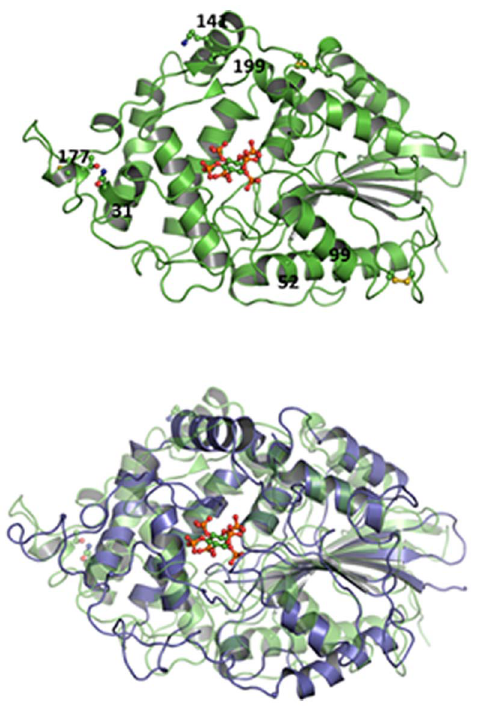
Figure 2. Disulfide crosslink design. Upper panel: structure of the homology model of the phytase from C. braakii used in Molecular Dynamics simulations showing the residues mutated to introduce disulfide bridges. Bottom panel: superposition of the MD structures at 500 K and low temperature (blue and green, respectively). Regions targeted for disulfide bridge engineering are those showing significant displacement between the two structures.